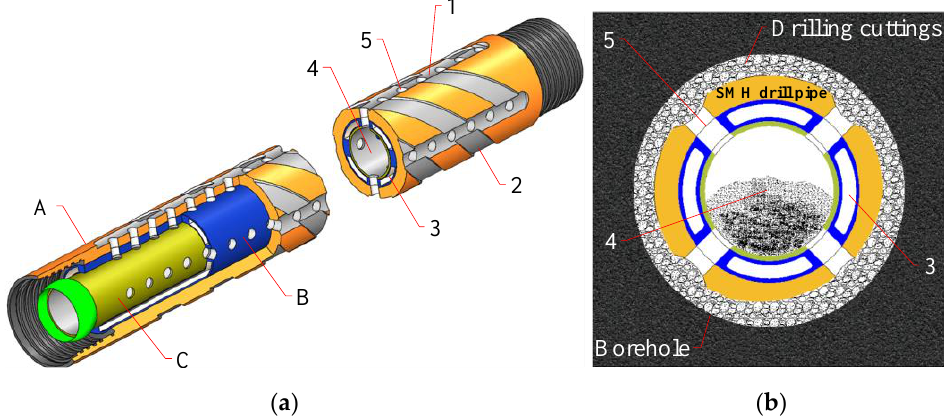
Figure 2. Structure of SMH drill pipe. ( a ) Three-dimensional structure; ( b ) cross section of SMH drill pipe in borehole. A. Bearing layer; B. fluid layer; C. anti-sparking layer. 1. Axial grooves; 2. spiral grooves; 3. fluid channel; 4. inner hole; 5. sieve hole.